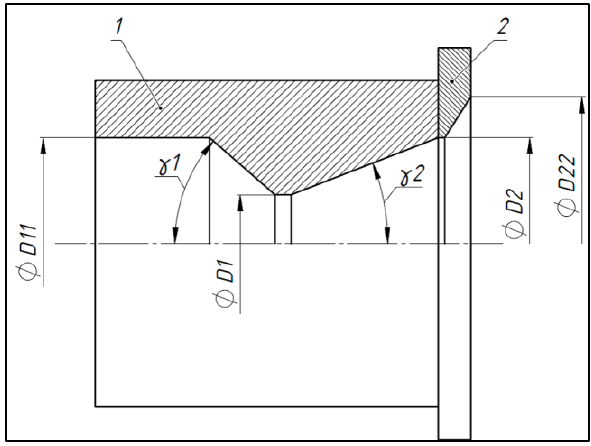
Figure 23. Structural model of a nozzle with a movable diaphragm: 1- nozzle; 2- the movable diaphragm. A 3D model of a nozzle with a movable diaphragm is shown in Figure